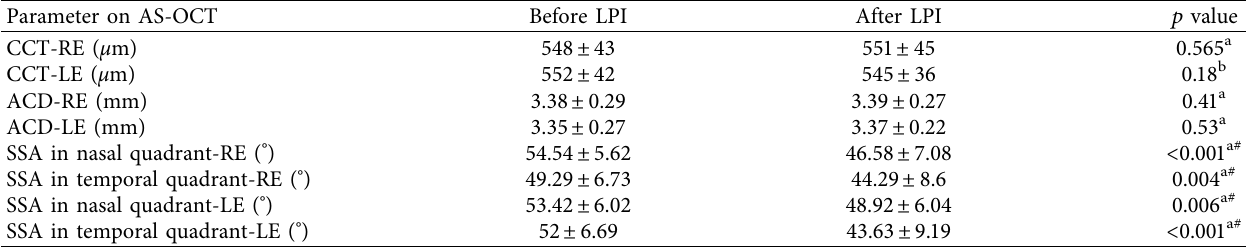
Table 1: Changes in parameters of the anterior segment: central corneal thickness (CCT), anterior chamber depth (ACD), and scleral spur angle (SSA) before and after the laser treatment.